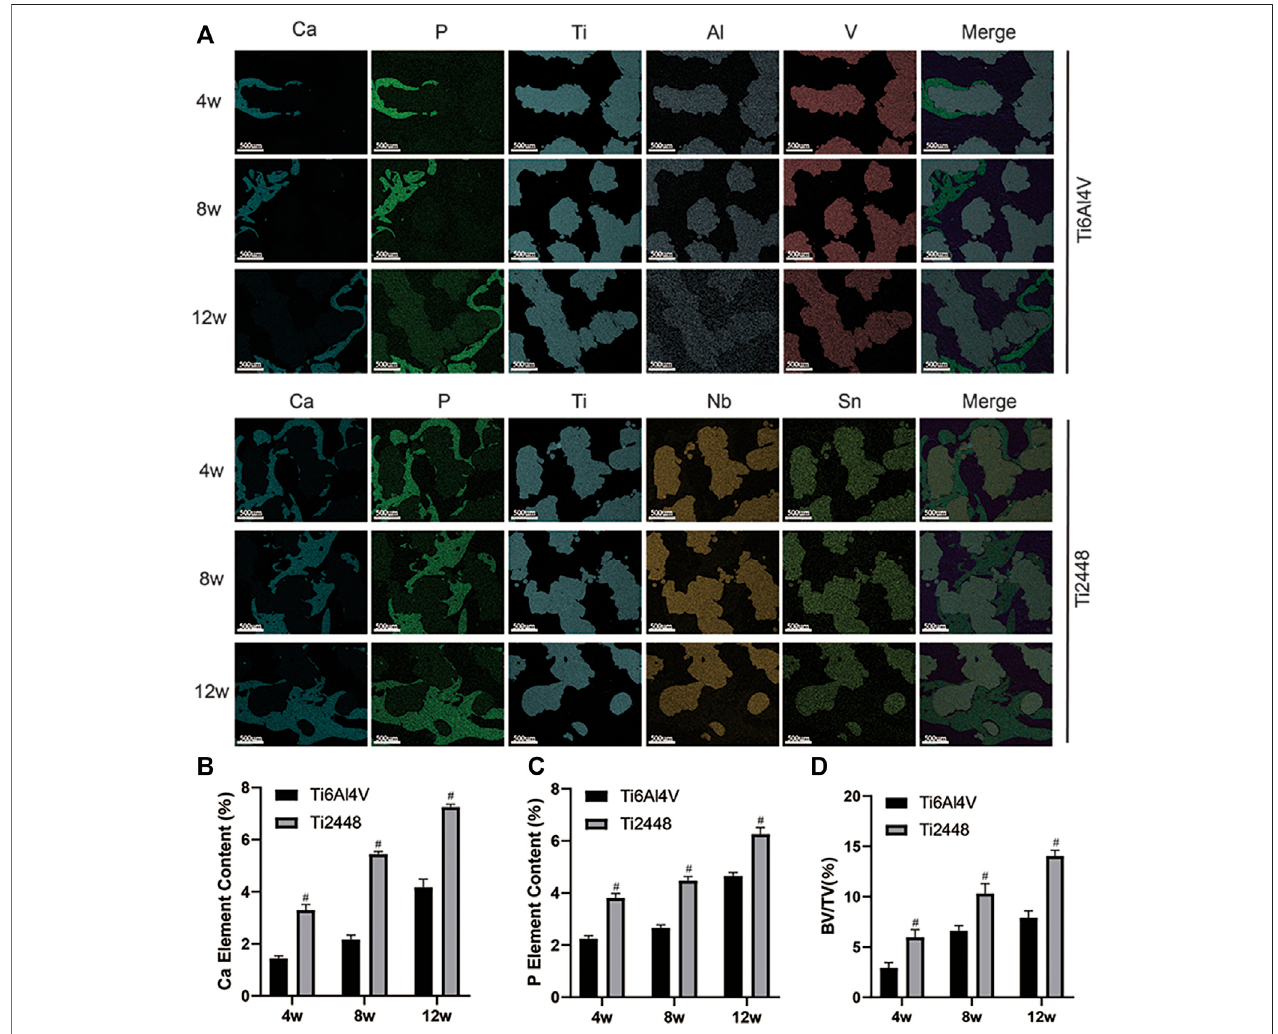
FIGURE3 | Assessmentofosteogenesis byEDS. Elemental composition ofdifferent groups ofscaffoldsat 4,8 and 12 weeks detectedby SEM-EDS. Scale bar (cid:2) 500 µm (A) . Quantitative analysis of the elemental Ca content of different scaffolds at 4, 8 and 12 weeks (B) . Quantitative analysis of the elemental P content of different scaffolds at 4, 8 and 12 weeks (C) . Quantitative analysis of the BV/TV of different scaffolds at 4, 8 and 12 weeks (D) . Note: # p ＜ 0.05 compared to Ti2448.